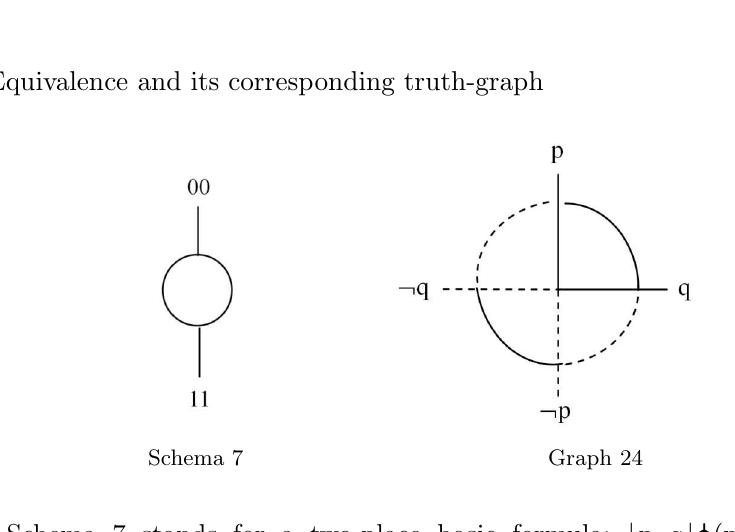
Schema 6 stands for a two-place basic formula: ⌊ p q ⌋ (pq), while graph 23 (also see graph 9 (d)) stands for an assertion: ⊢ ¬ p ∧ q. Schema 6 and graph 23 all show that an expression is true iff ‘p’ is false (has value 0) and ‘q’ is true (has value 1).